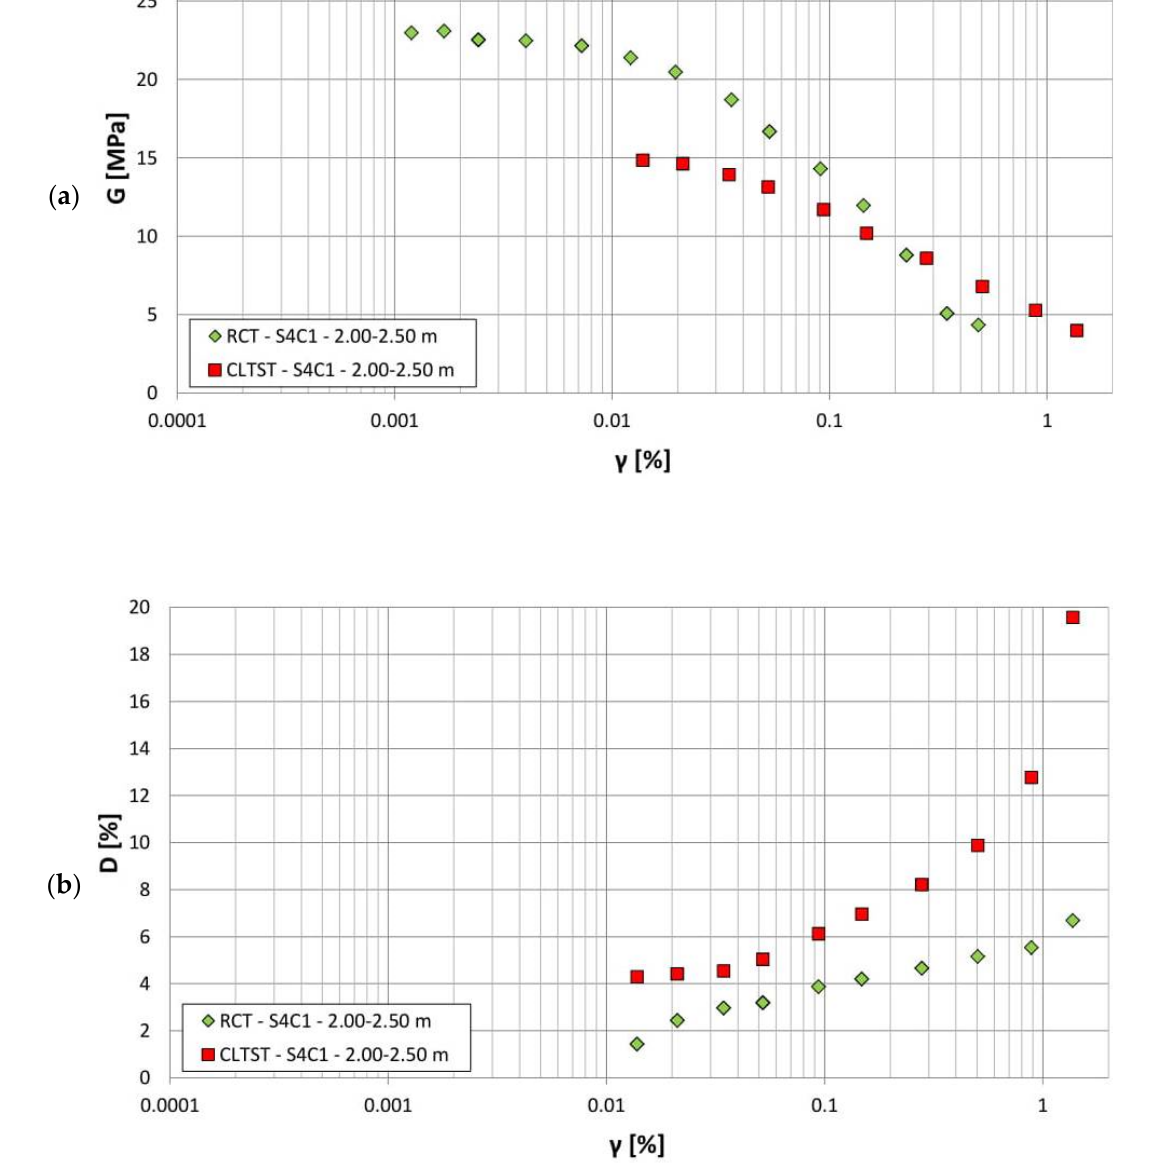
Figure 9. ( a ) G [MPa] versus γ [%] curves. ( b ) D [%] versus γ [%] curves (for the S4C1 soil